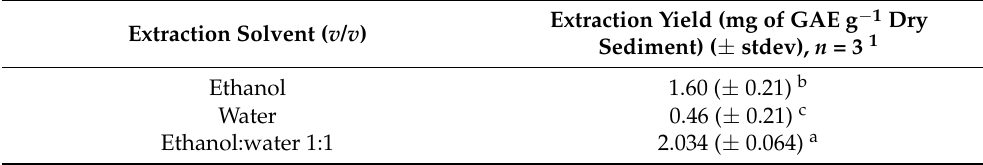
Table 1. Extraction yields of the three investigated solvent systems expressed as total phenolic content (mg GAE g − 1 dry